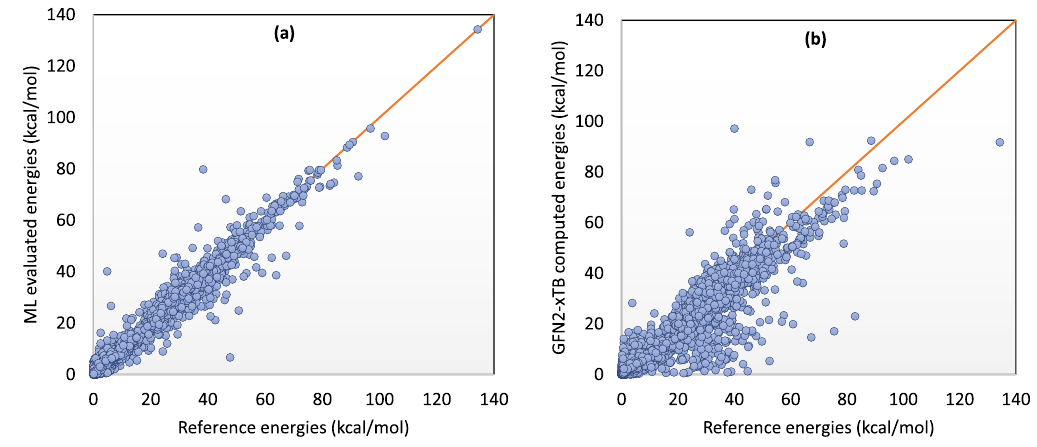
Fig. 2 Comparison of reference CCSD(T) and evaluated energies. A comparison of the reference energies with energies evaluated by machine learning based on ImPerHam representations ( a ) and computed by GFN2-xTB method ( b ) shows that the machine learning-based method results in a remarkably better agreement with the reference